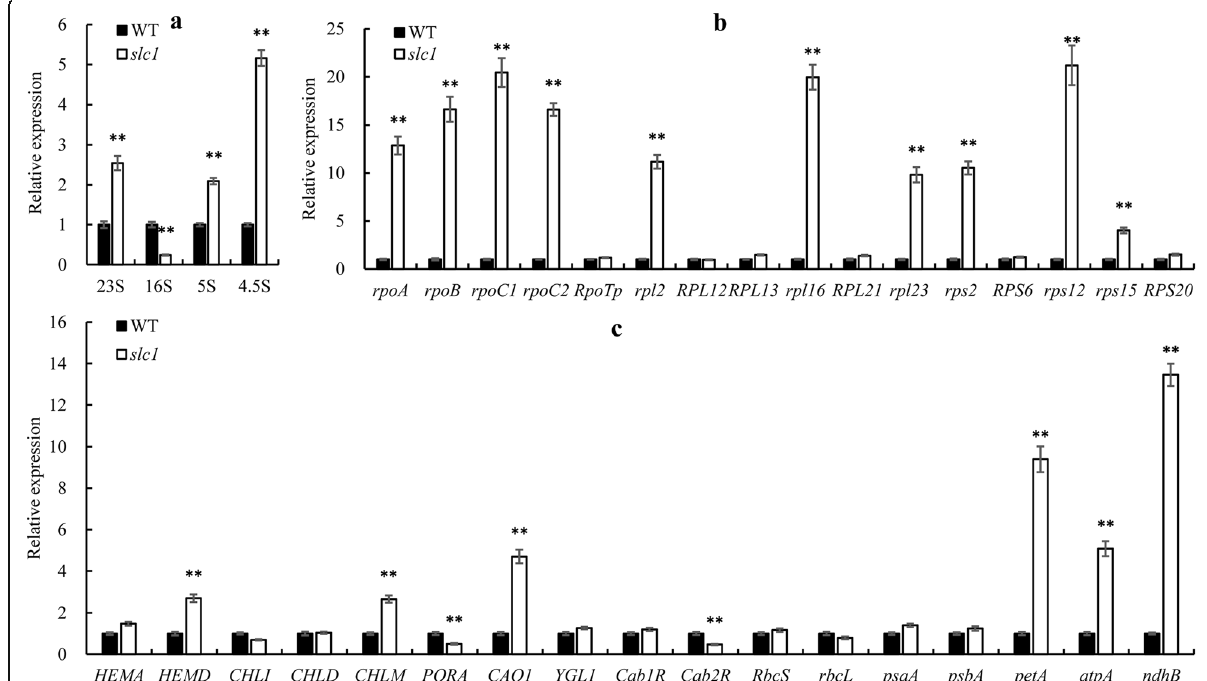
Fig. 7 Quantitative real-time PCR analysis of genes associated with chloroplast development and photosynthesis in the wild type and slc1 mutant leaves at the third-leaf stage. a Transcript analysis of chloroplast 23S, 16S, 5S and 4.5S rRNAs. b Transcript analysis of plastid-encoded and nucleus- encoded chloroplast development-related genes. c Transcript analysis of chlorophyll synthesis-related and photosynthesis-related genes. OsActin1 and OsUbiquitin were used as double internal controls, and relative transcript levels were analyzed using the 2 - ΔΔ CT method (Livak and Schmittgen 2001). Three biological replicates were performed. Error bars are SDs. The asterisks indicate statistical significance between the wild type and slc1 mutant, as determined by Student ’ s t-test (** P <